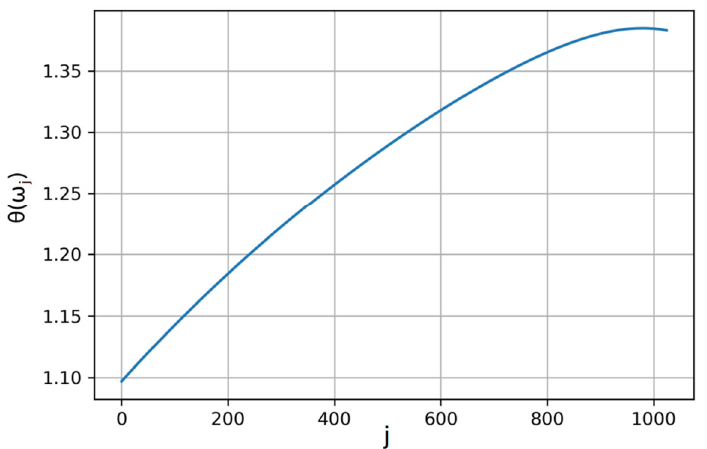
Figure 5. The sequence of 𝜃 values preserving irreversibility at both scales simultaneously for j > 0. (Note that for j = 0, θ ( ω 0 ) = 0 for j < 0, θ ( ω j ) = − θ ( ω – j ).